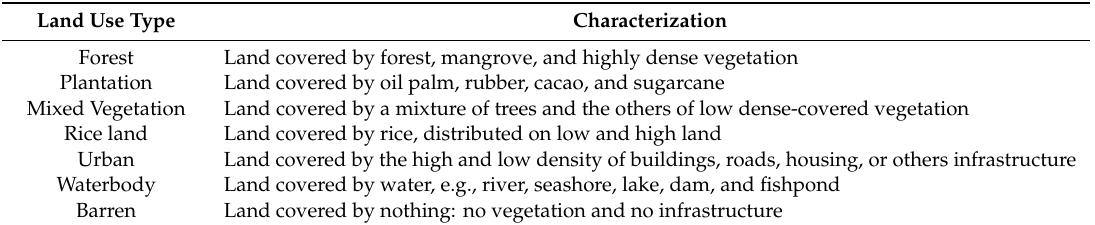
Figure 2. The research framework, where LU for Land Use, ASCII for American Standard Code for Information Interchange, and PCA for Principle Component Analysis. Table 1. Characterization of land use types for image